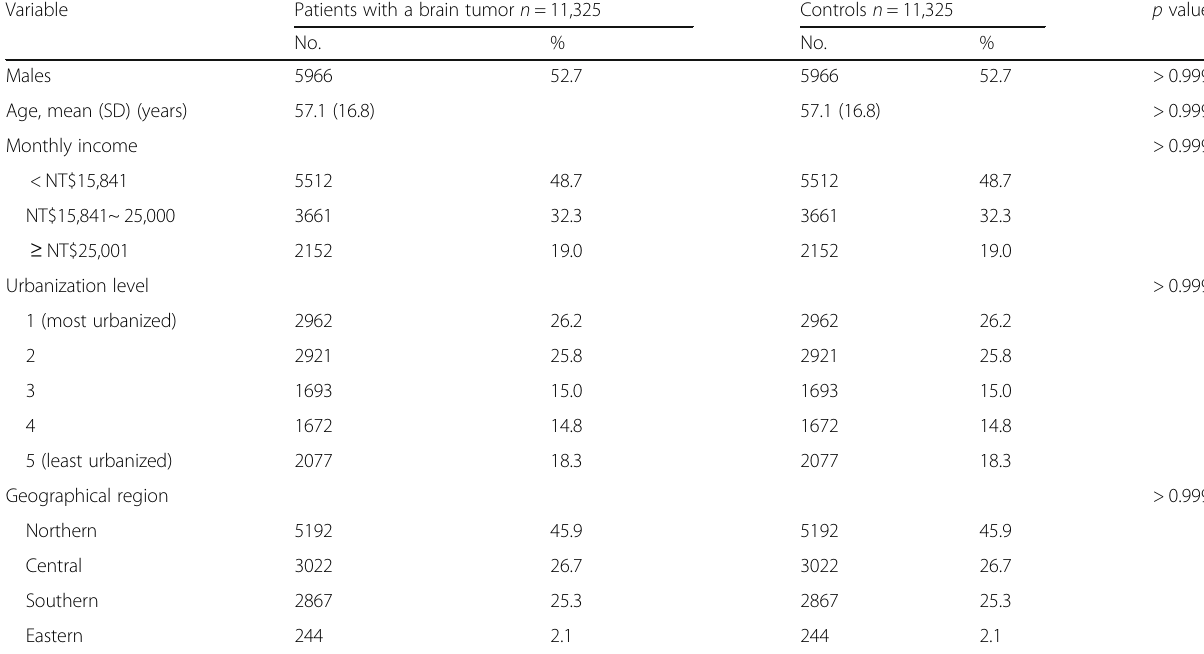
Table 1 Patients with brain tumors and controls -- sociodemographic characteristics ( n =22,650) Variable Patients with a brain tumor n = 11,325